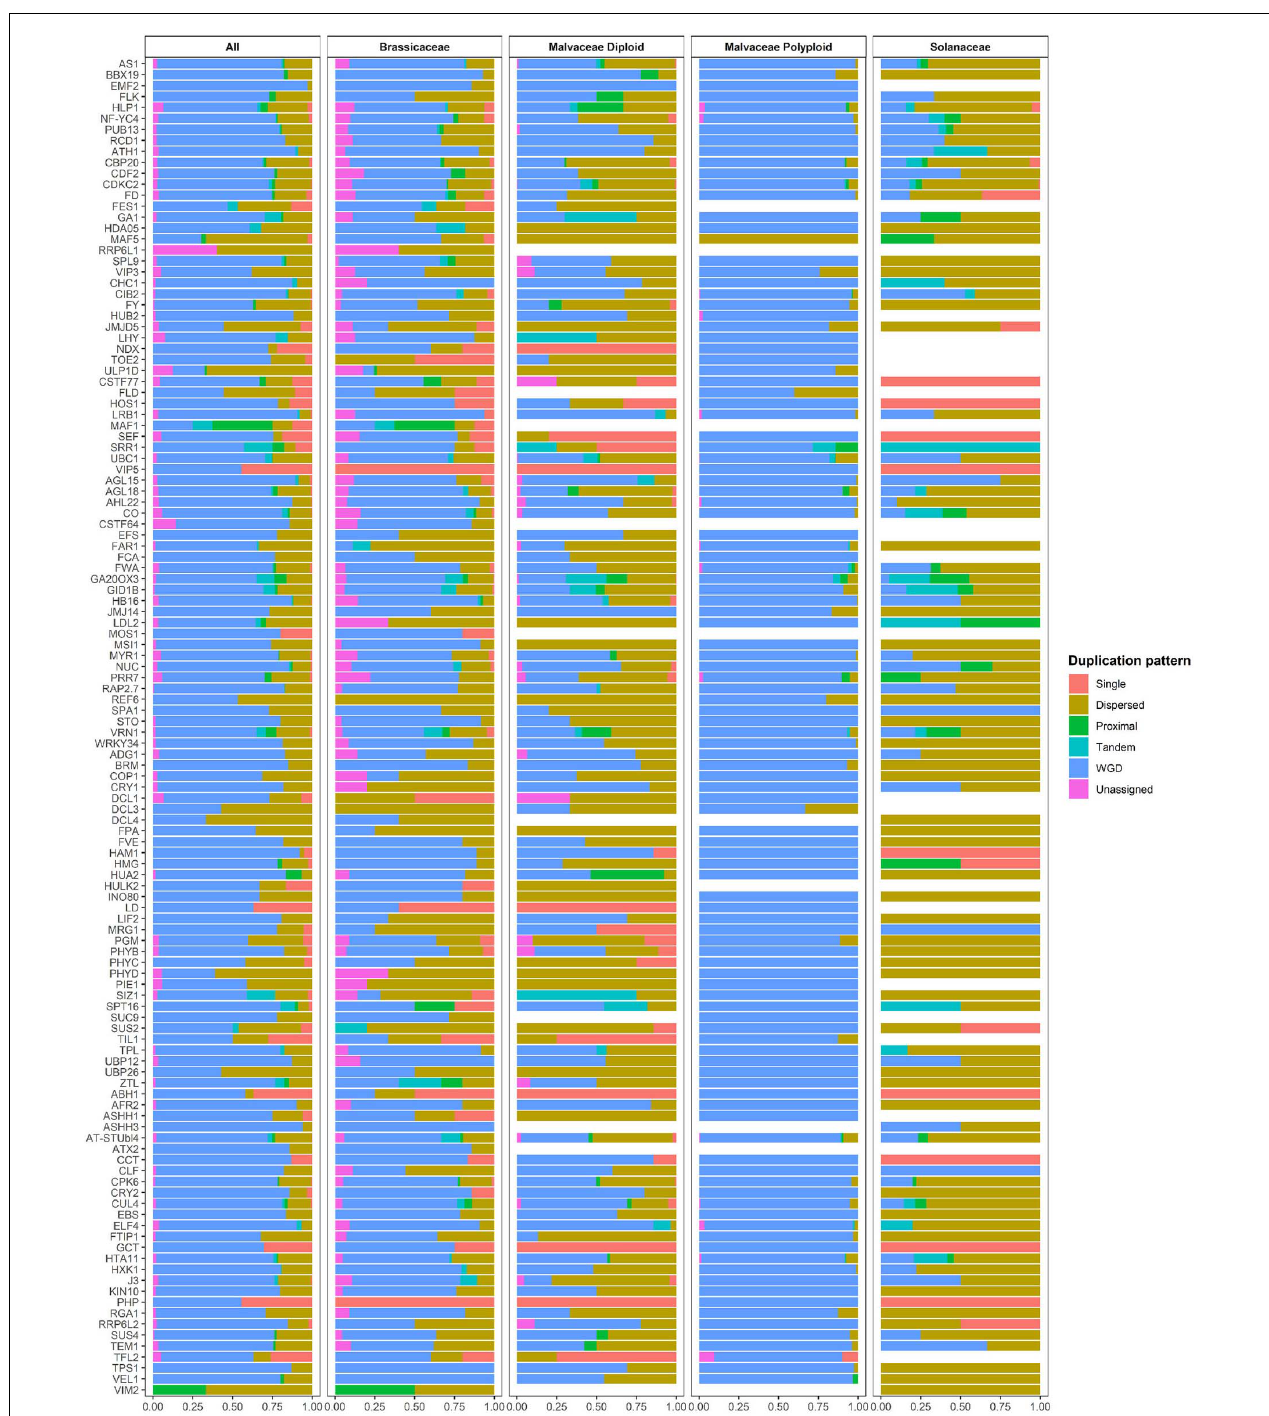
FIGURE 3 | Duplication pattern analysis of flowering-time genes. Flowering-time genes were analyzed using MCScanX, and duplication patterns were classified as singleton, dispersed, proximal, tandem, segmental/whole genome duplication (WGD), or unassigned.